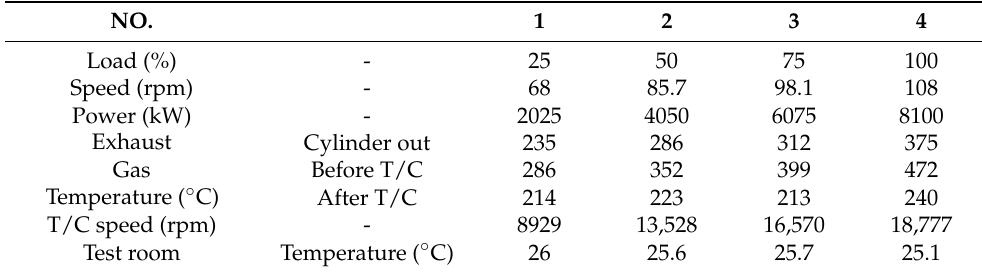
Table 3. Partial test data of the DIDF mode.